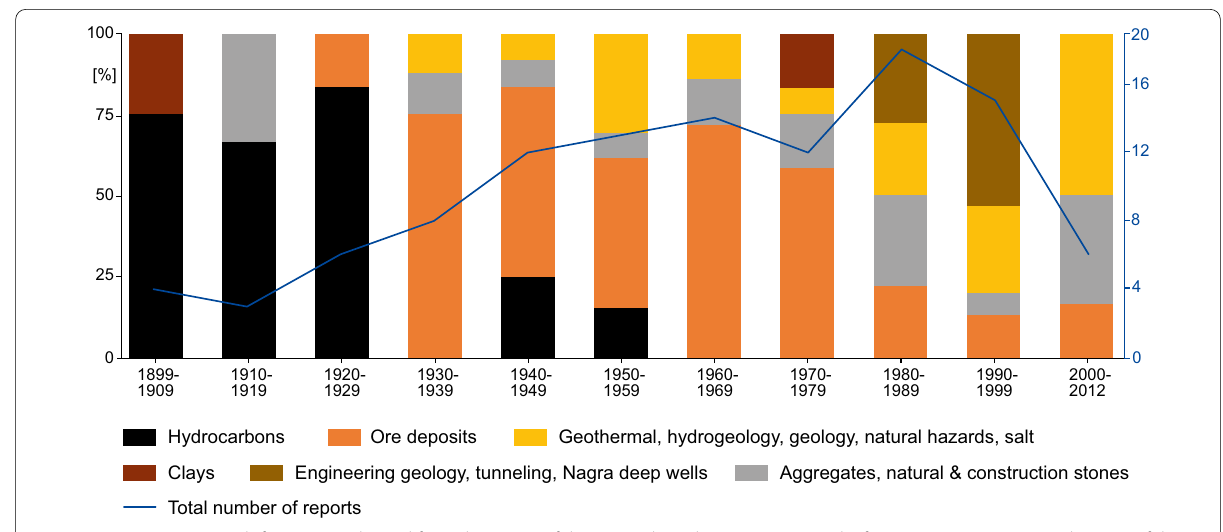
Fig. 11 Main SGTK research focus areas derived from the topics of the Geotechnical Series monographs from 1899 to 2012. Vertical axis: % of the total amount of reports. Note (1) the clear focus on hydrocarbons in the first three decades, (2) the shift in the 1930s towards ore deposits, (3) the hydrocarbons interlude in the 1940s and 50s, (4) the increasing diversification from the 1970s onwards and (5) the fast decline of number of reports